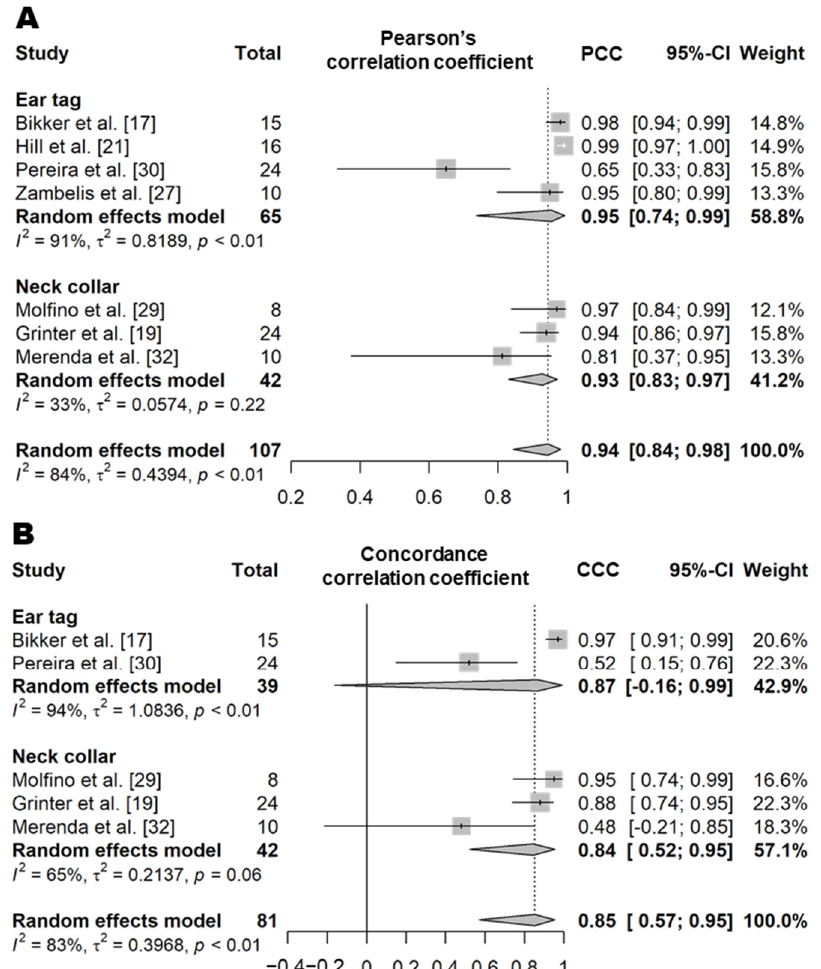
Figure 11. Forest plot of the correlation coefficient of inactive time between wearable sensors and visual observation. ( A , B ) show Pearson’s correlation coefficient and concordance correlation coefficient, respectively. Numbers in parentheses indicate individual studies applying different evaluation conditions within the same article. ‘Total’ means the sample size of each study and ‘Weight’ means the weight for the mean based on the sample size.